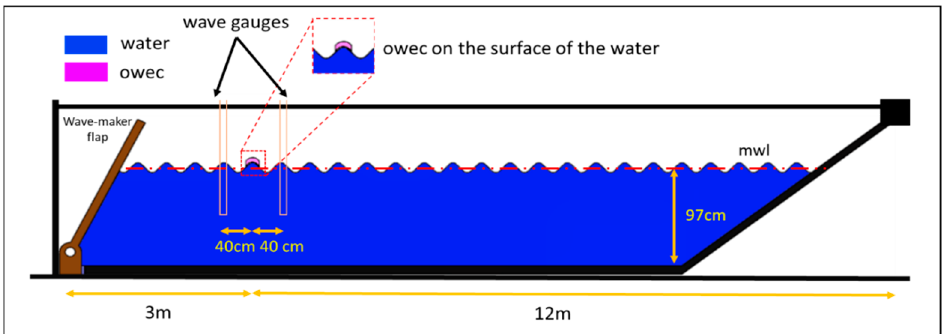
Figure 4. The schematic diagram of the wave flume and experimental setup (not to scale). OWECs were placed at a distance of 3 m from the wave maker. The total length of the flume was L = 15 m, and its width was W = 0.6 m. The height of the water was adjusted to H = 0.97 m during the exper- iments (L = 15 m × W = 0.6 m × H = 0.97 m). The wave gauges are also